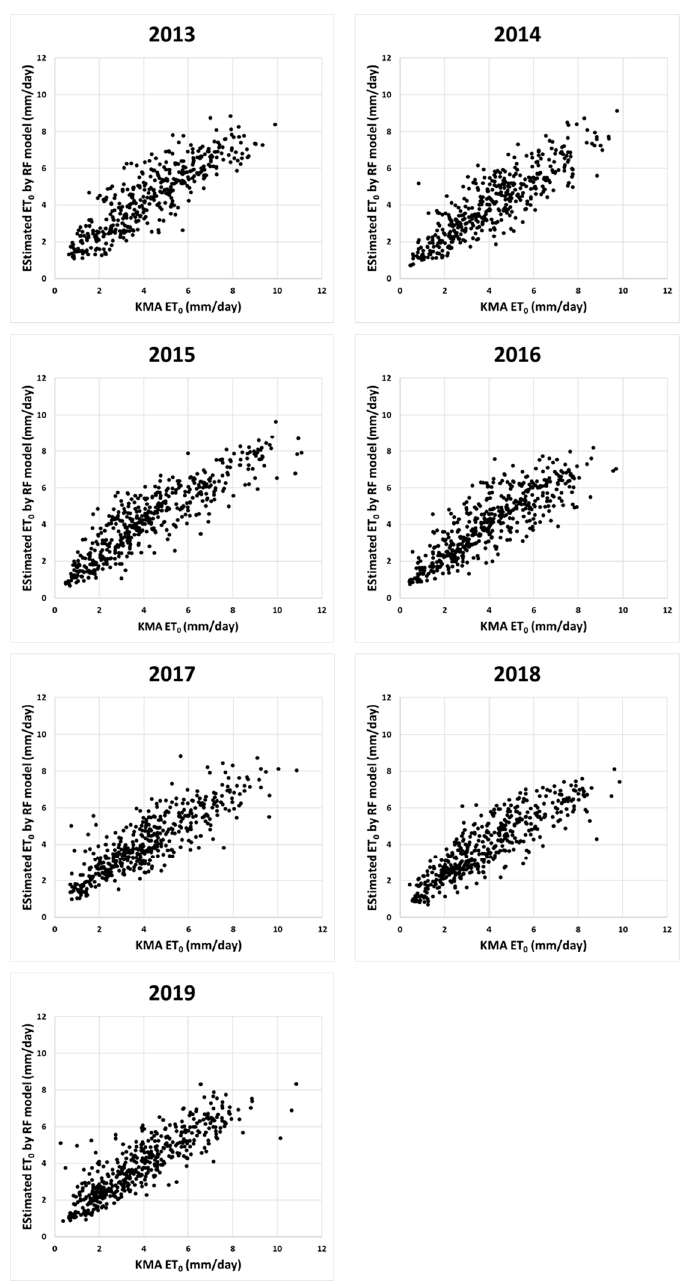
Figure 9. Scatterplots for the observed vs. estimated daily ET 0 in the blind test of the ML model in the croplands of South Korea, according to year.